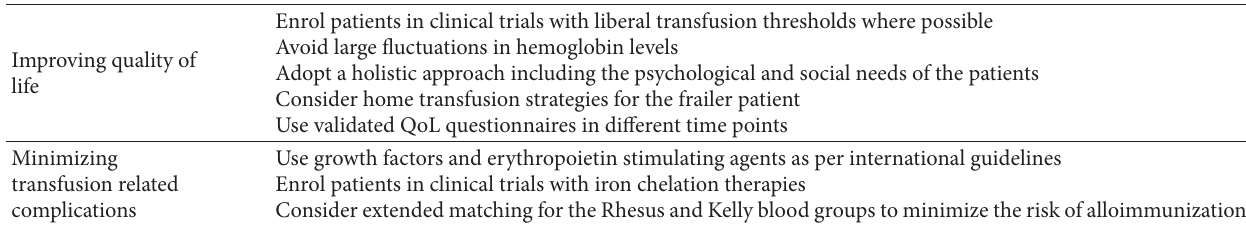
Table 1: Practical considerations in